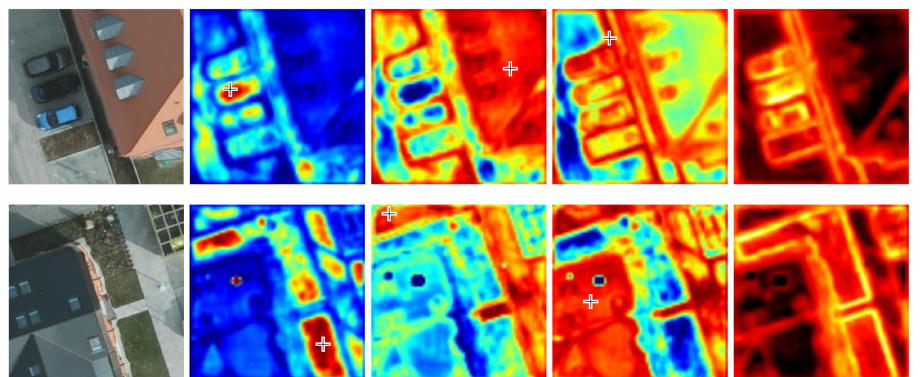
Figure 8. Visualization of attention weights in DNL block. Query points are marked by crosshairs. The first column is the original TOP images, the second to fourth columns display the attention weights of the whitened pairwise term, and the fifth column shows the attention weights of the unary